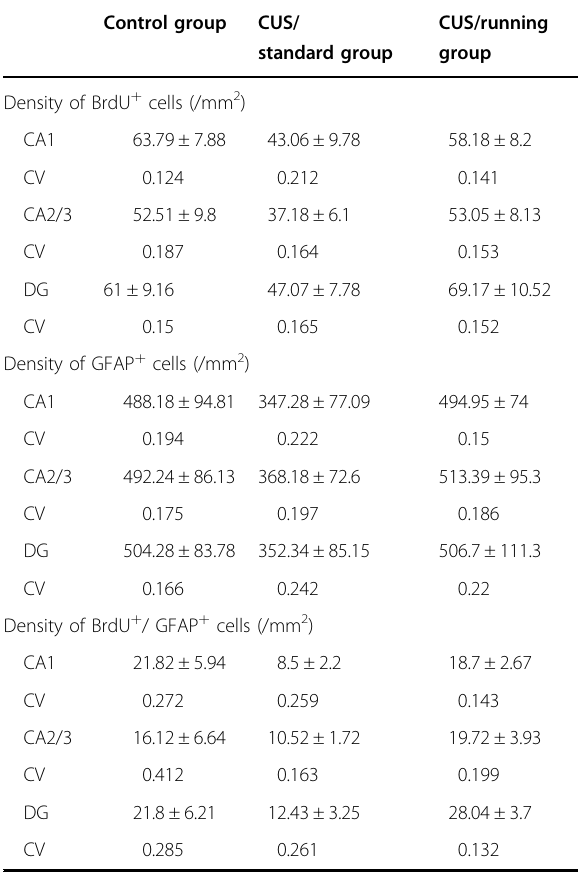
Table 5 The density of BrdU + , GFAP + , and BrdU + / GFAP +